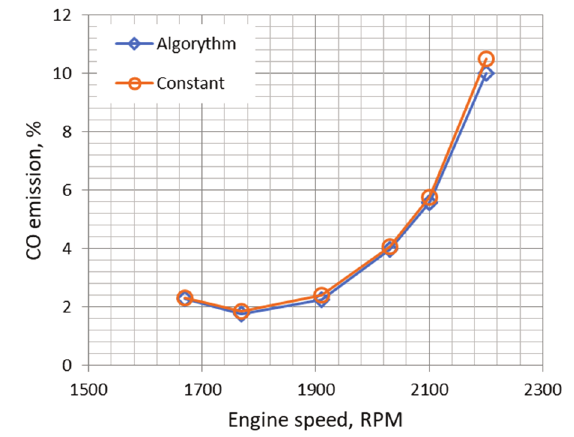
Fig. 9. Relationship between CO emission and rotational speed for con- stant and variable ignition advance angle